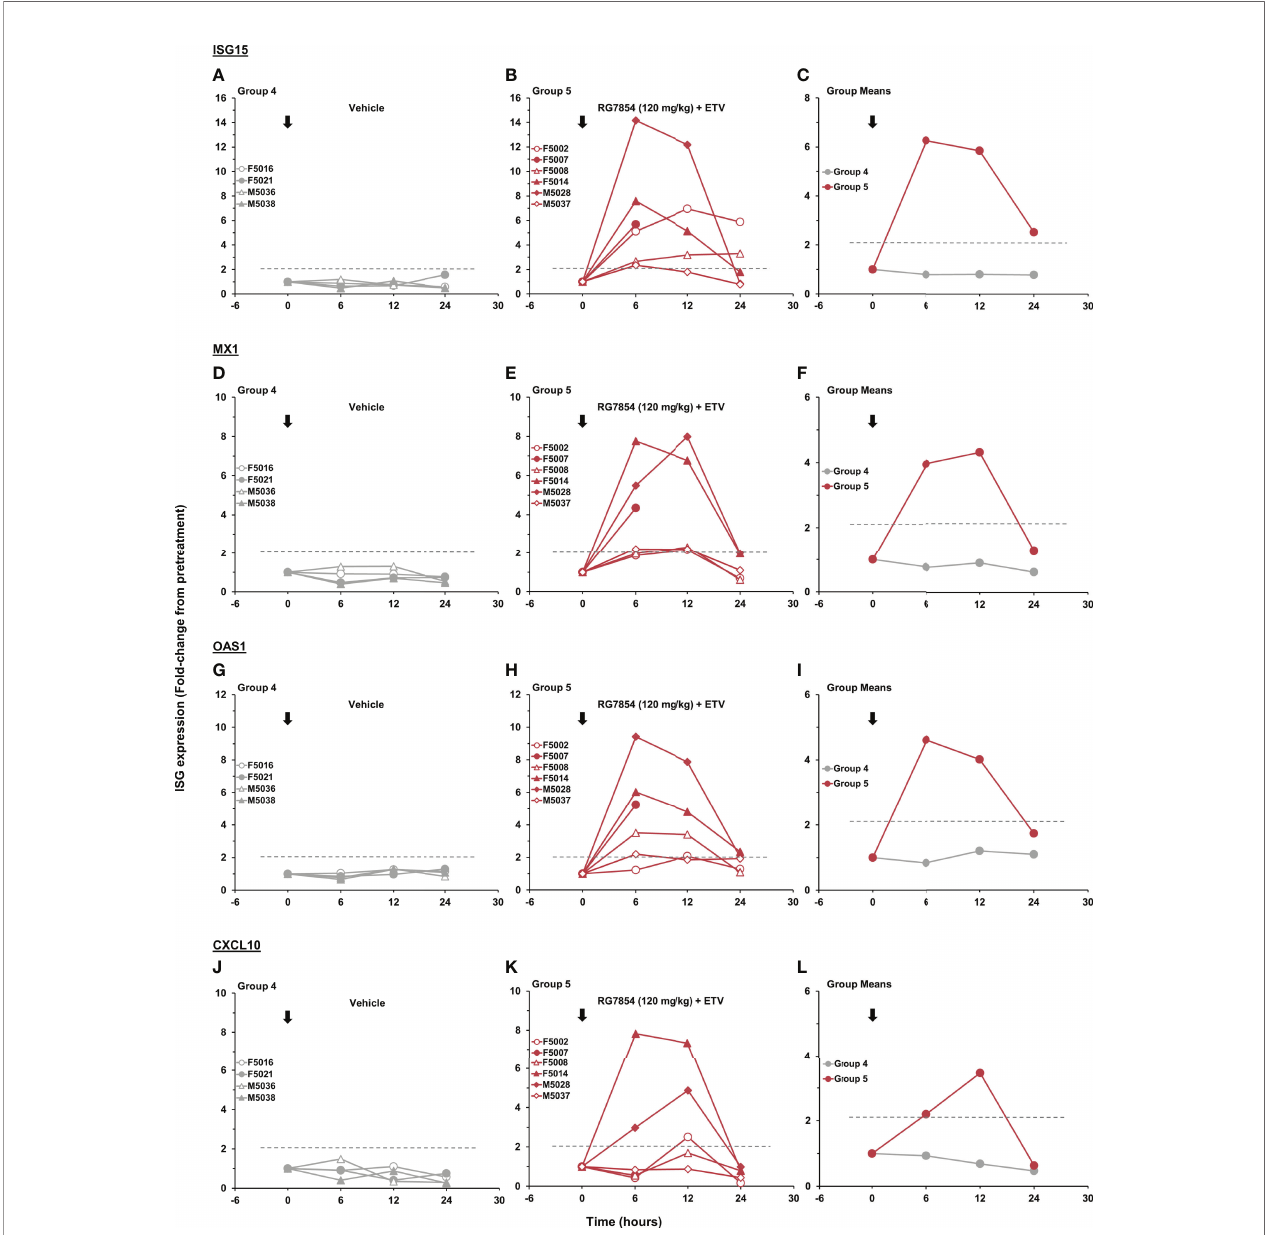
FIGURE 6 | Effect of the fi rst dose of RG7854 together with ETV on peripheral ISG transcription. Kinetics of ISG15 , MX1 , OAS1 , and CXCL10 gene expression in individual woodchucks prior to (0 hours) and 6-, 12-, and 24-hours post administration of the fi rst dose of (A, D, G, J) placebo or (B, E, H, K) RG7854 at 120 mg/ kg plus ETV in the combination treatment study. (C, F, I, L) Group mean ISG transcription levels. The horizontal dotted lines indicate the cutoff for positive gene expression (i.e., ≥ 2.1-fold increase from the pretreatment baseline). The mean transcription levels of ISG15 , MX1 , and OAS1 in Group 5 were signi fi cantly increased compared to Group 4 at 6 and 12 hours, at 6 hours, or at 6 hours, respectively ( P < 0.05) (Student ’ s t -test). The mean CXCL10 transcription level in Group 5 was not signi fi cantly different to Group 4 ( P >